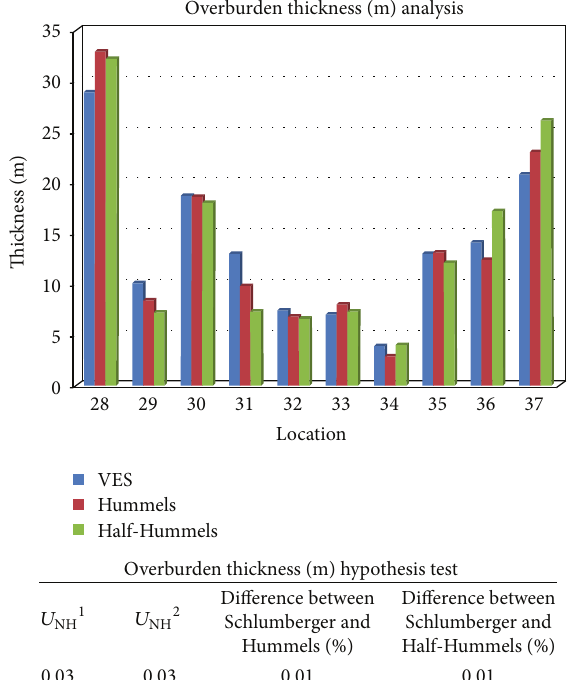
Figure 7: Bar chart and statistical test of hypothesis table for the different array methods comparing Overburden thickness for locations on quartz